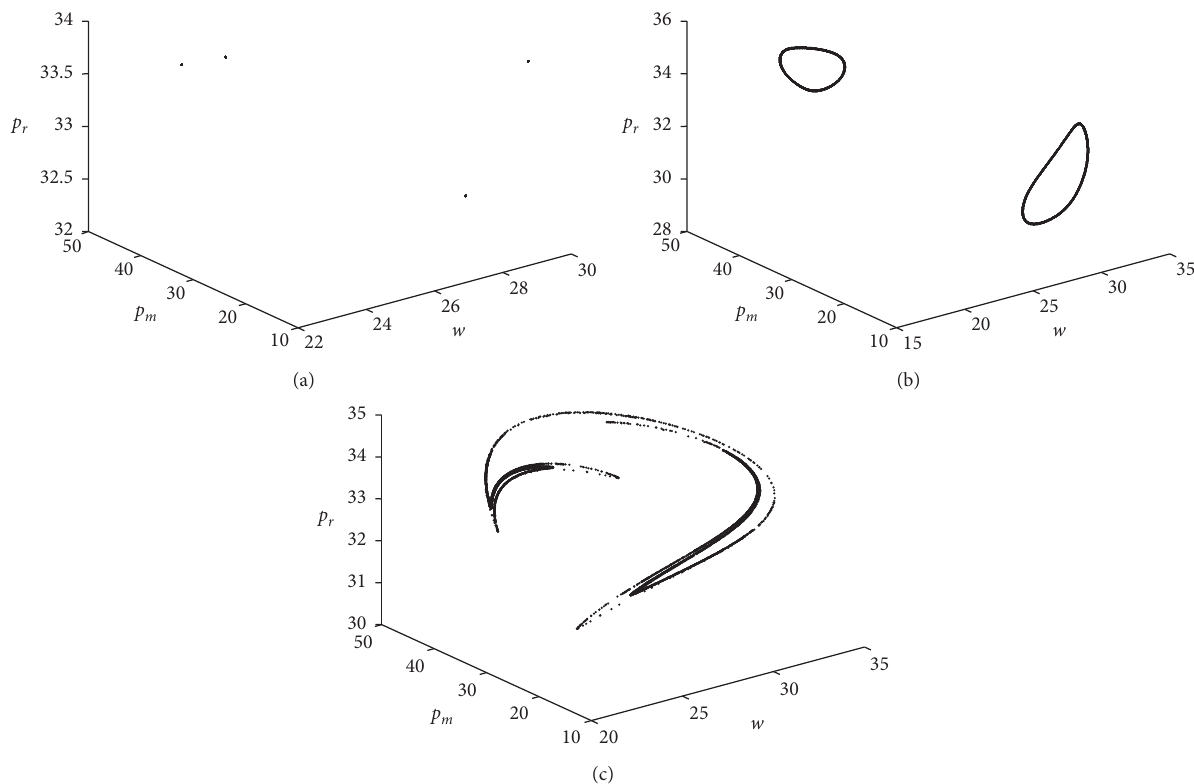
Figure 6: Chaos attractors of the system (17) with (a) α